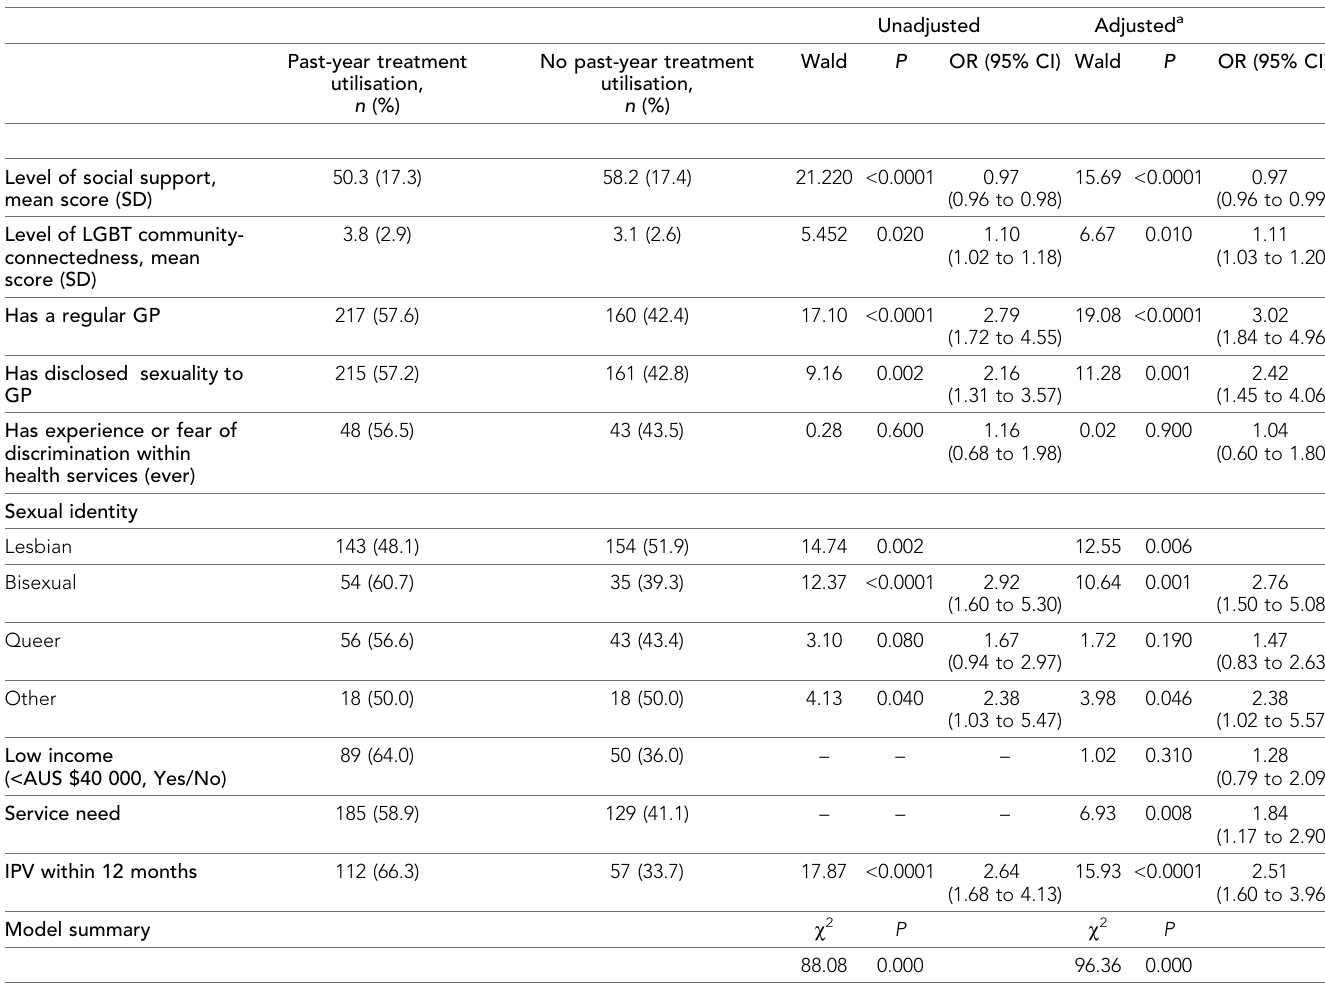
Table 3. Binary logistic regression model of influences on past-year treatment utilisation for mental health or alcohol-related